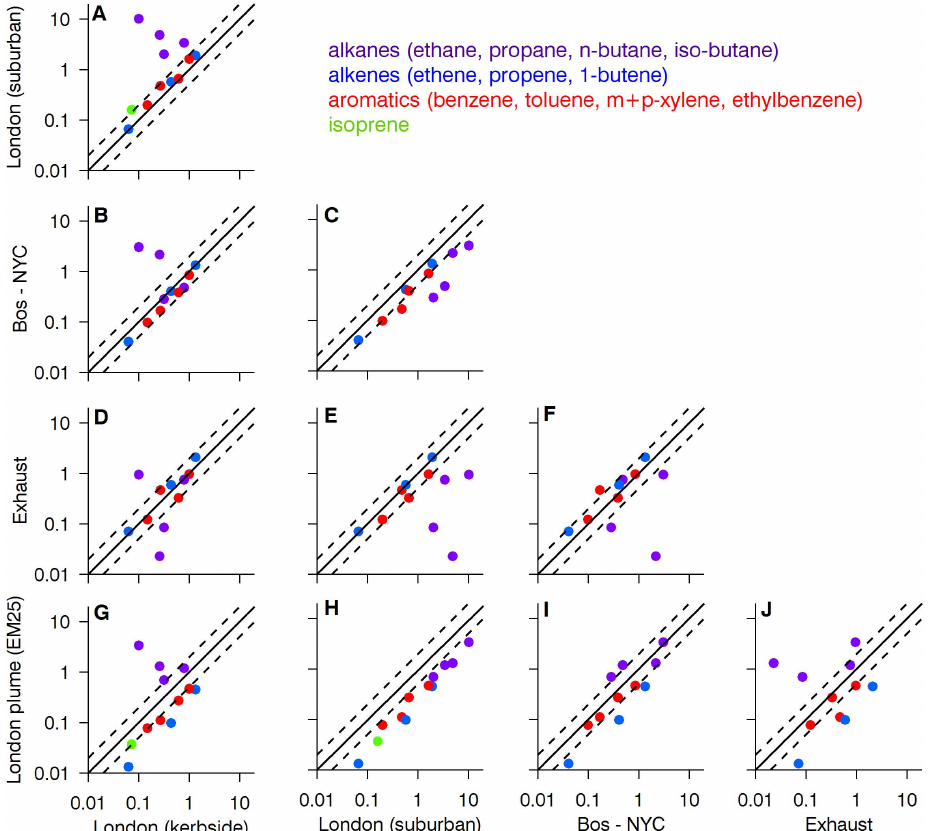
Fig. 6. Selected volatile organic compound (VOC) emission ratios to acetylene (C 2 H 2 ) measured on the FAAM BAe-146 research aircraft for samples with photochemical age less than 20h, at ground sampling sites in London, and by previous measurement campaigns. Bos-NYC refers to emission ratios measured in the outflow of the north-eastern US reported by Warneke et al. (2007), exhaust refers to vehicle exhaust emission ratios reported by Harley et al. (1992), and the London (kerbside) and London (suburban) data were obtained from the Marylebone Road and Eltham automated hydrocarbon monitoring network locations for June/July 2008–2010. Points are shaded by VOC family as alkanes, alkenes and aromatics. The solid line gives the 1:1 relationship and the dashed lines 2:1 and 1:2 relationships; all axes are log-scaled and